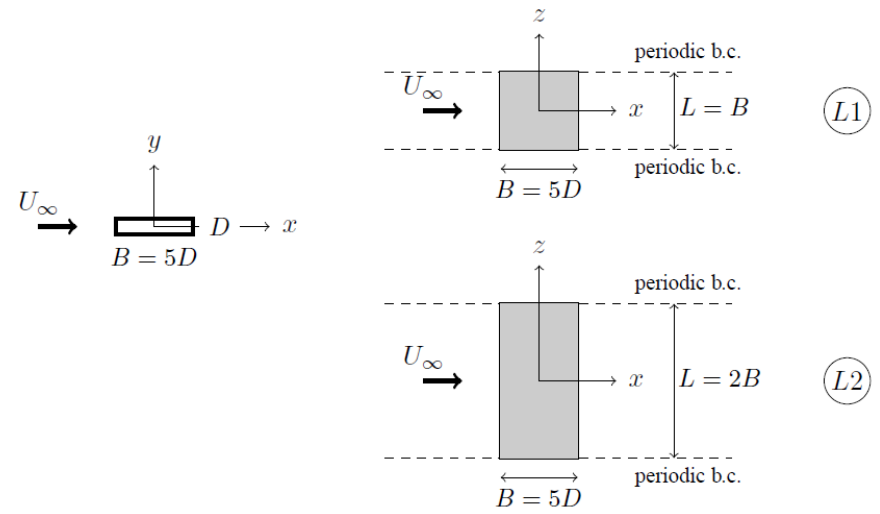
Figure 8. Scheme of the 3D detached eddy simulations (DES) for the rectangular 5:1 cylinder.